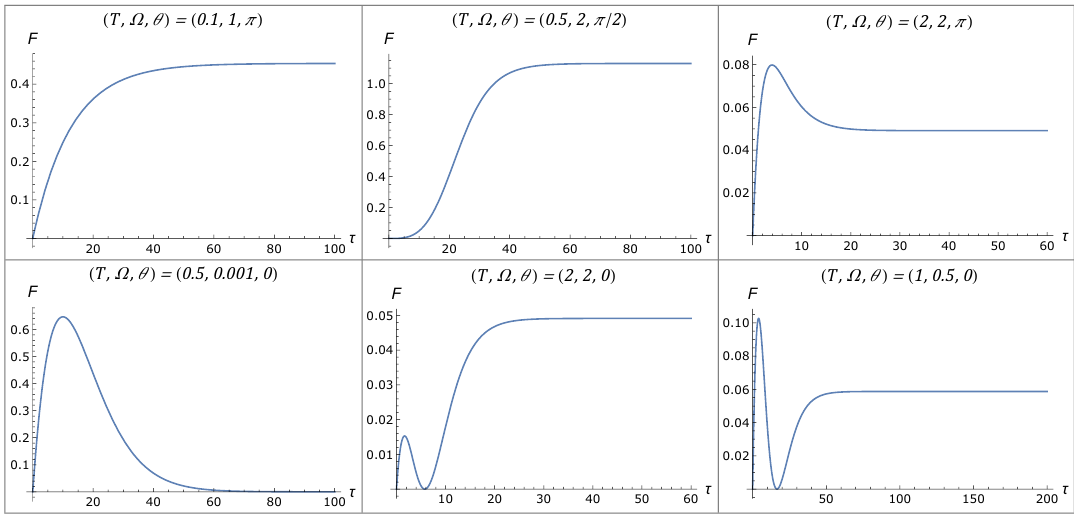
Figure 1 . A gallery of different qualitative behaviors of the time evolution of Fisher information in dS 4 . Only three of them (top row) were previously discovered in ref. [17].